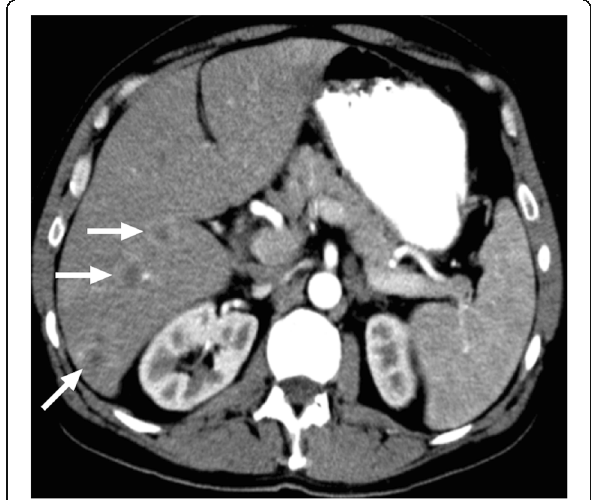
Fig. 12 A 48-year-old male with known HIV presenting with recent onset of abdominal pain and mild weight loss. Axial plane postcontrast arterial phase CT image demonstrates several peripherally enhancing liver lesions (arrows) located within the right lobe. Metastatic liver disease or pyogenic microabscesses were initially considered. Percutaneous biopsy was consistent with syphilitic liver abscesses. The RPR test was also found to be positive after the biopsy